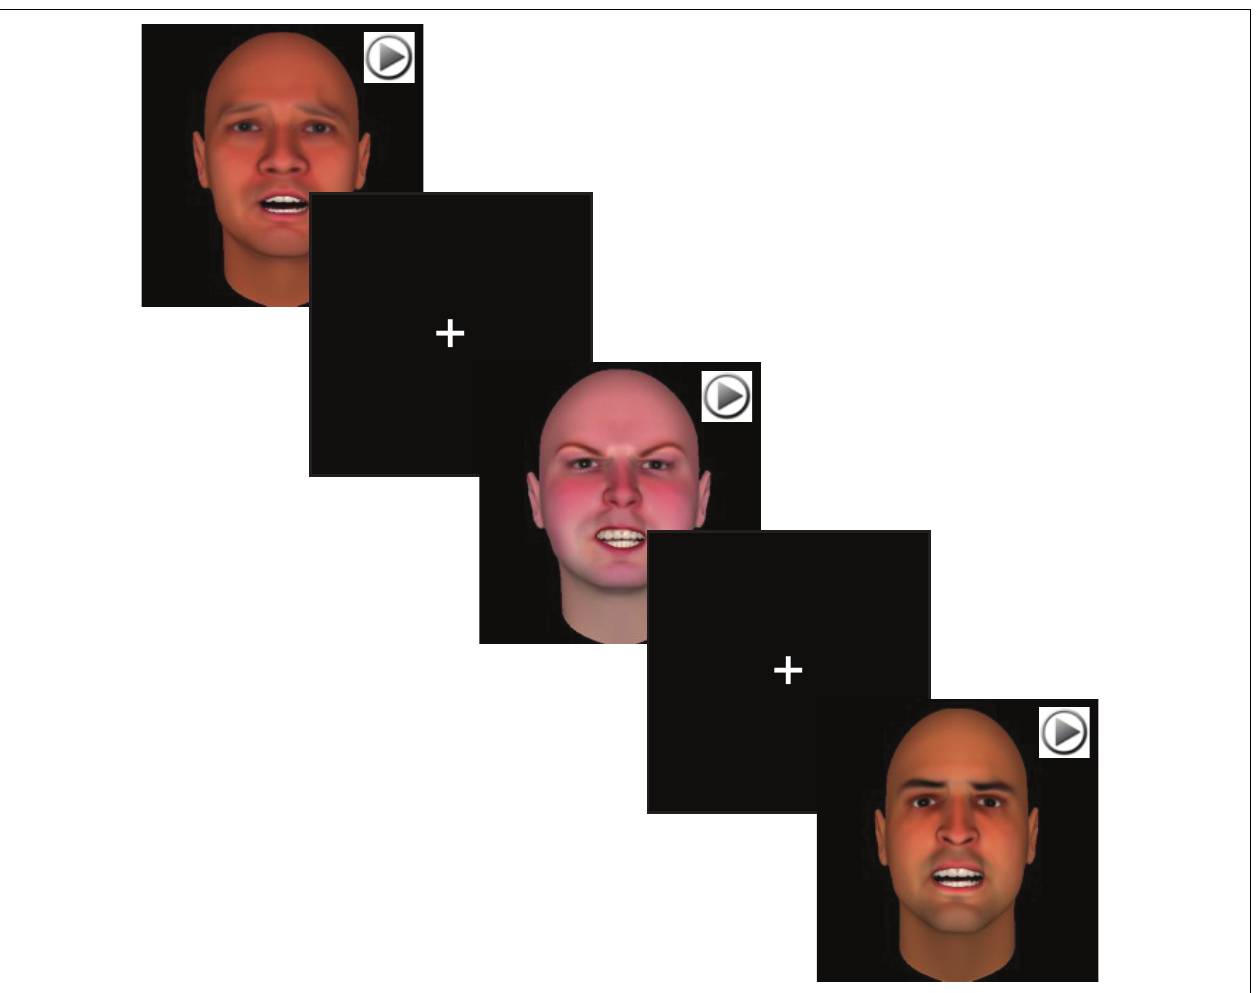
FIGURE 3 | Example of the sequence subjects observed. Each face was separated by a 3-s intertrial interval, and the sequence was Type 1, Index 1 counterbalanced (see Materials and Methods). Video play buttons are shown here for illustration, and were not seen by the subjects. From left to right: 20%, 100%, and 60% anger from three different